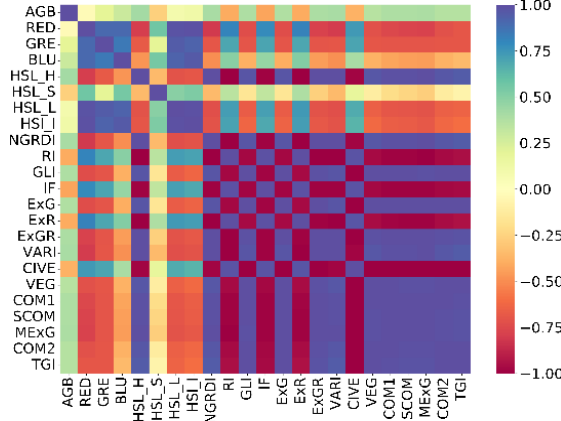
Figure 3. Pearson’s correlation coefficient (r) between wheat biomass and features derived from UAV visible images.